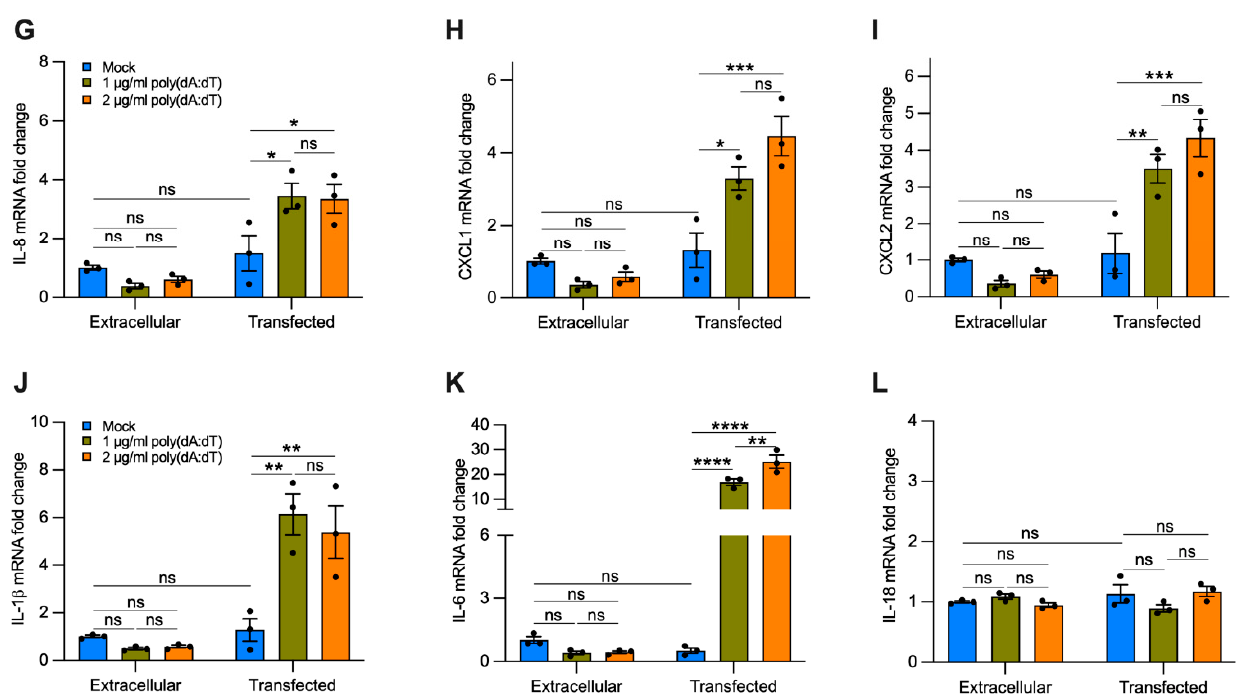
Figure 7. Transfected synthetic DNA upregulates the expression of DNase III, DNA-sensing receptors, and cytokines involved in neutrophil and macrophage recruitment. Bar graphs reporting the gene expression in cells exposed for 12 h to 1 or 2 µ g/mL of synthetic DNA added directly to the growth medium (extracellular) or transfected using a cationic lipid-based transfection reagent (transfected): ( A – C ) DNases I-III; ( D – F ) cGAS, NLRP3, TLR4; ( G – I ) IL-8, CXCL1, CXCL2; ( J – L ) IL-1 β , IL-6, IL-18. Data are shown as mean ± SEM of independent experiments ( n = 3), with each experiment indicated as a circle. ns, no statistical significance; * p < 0.05, ** p < 0.01, *** p < 0.001, **** p < 0.0001 were determined by two-way ANOVA with multiple